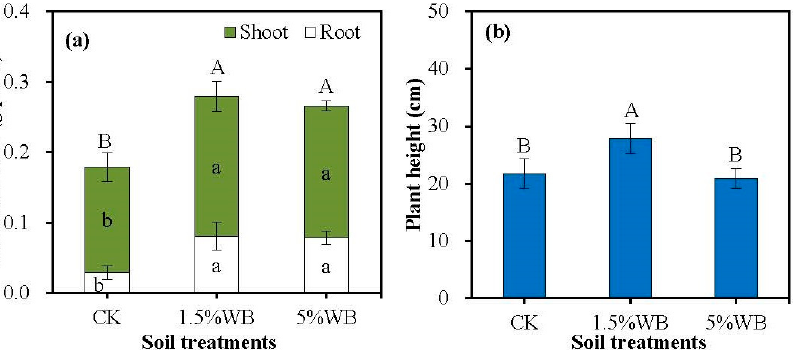
Figure 1. Effect of wood waste biochar (WB) on fresh biomass of root and shoot ( a ) and plant height ( b ) of the wild soybean. CK: soil treatment without WB amendment; 1.5% WB and 5% WB: soil amended with WB at the rate of 1.5% and 5.0% ( w / w ). Different small letters on the bars indicated the significant difference of fresh biomass in shoot and root between different treatments (Tukey’s HSD test, n = 3, p < 0.05). Different capital letters on the bars indicated significant difference of fresh biomass and height for the plant between different treatments (Tukey’s HSD test, n = 3, p <